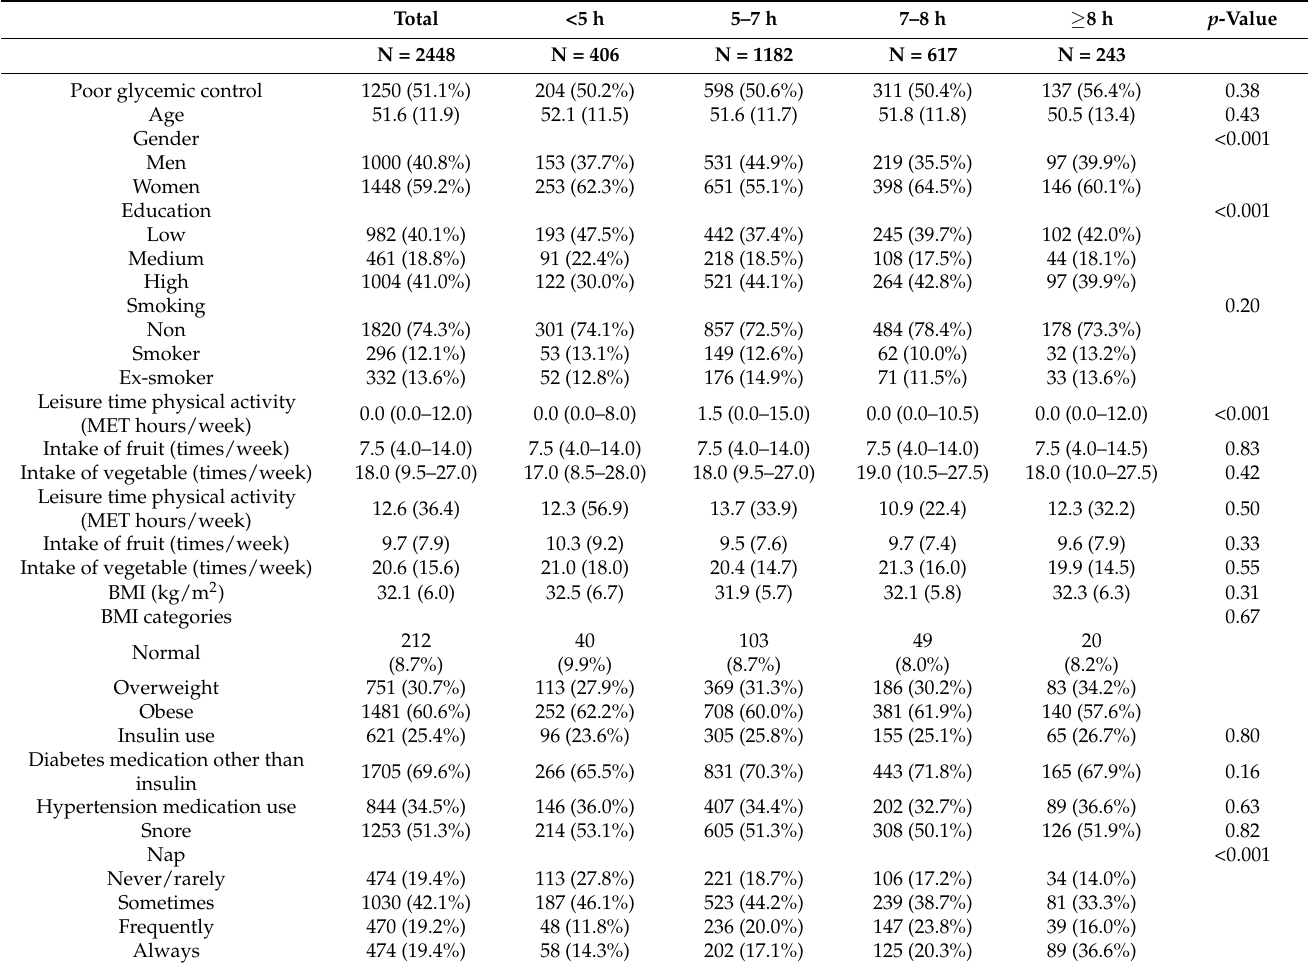
Table 1. Sample characteristics by sleep duration.